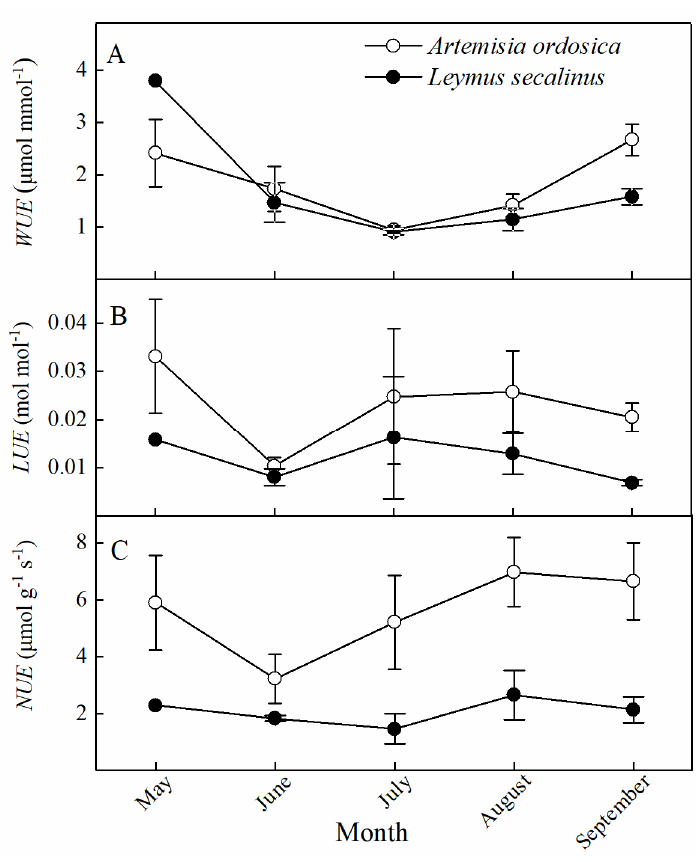
Figure 6. Monthly water ( A ), light ( B ), and nitrogen use efficiencies ( C ) (i.e., WUE , LUE , and NUE ) from May − September 2109. Bars indicate standard error of estimate.